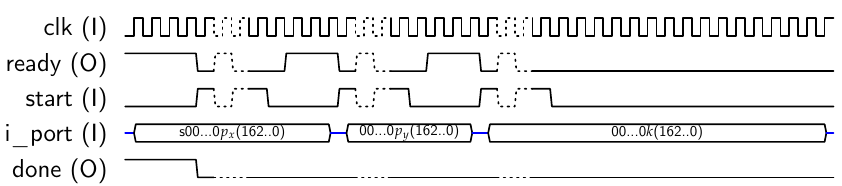
Figure 14. Sequence for loading p x input data.